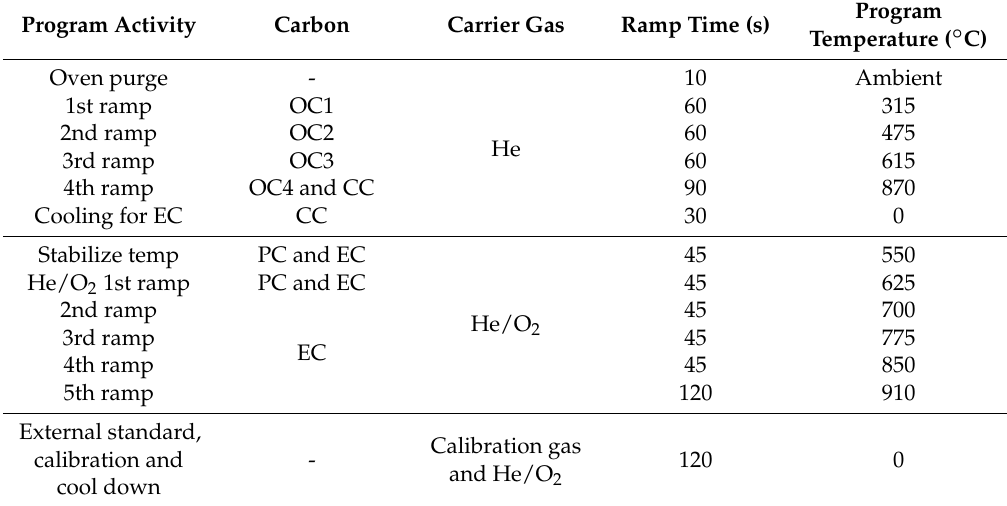
Table 2. NIOSH Method 5040